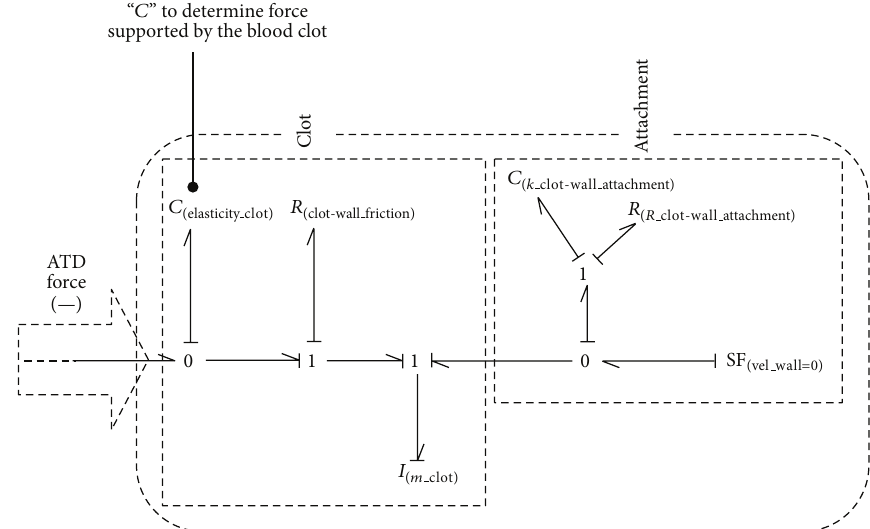
Figure 4: The simplest blood clot model by Bond-Graph technique.